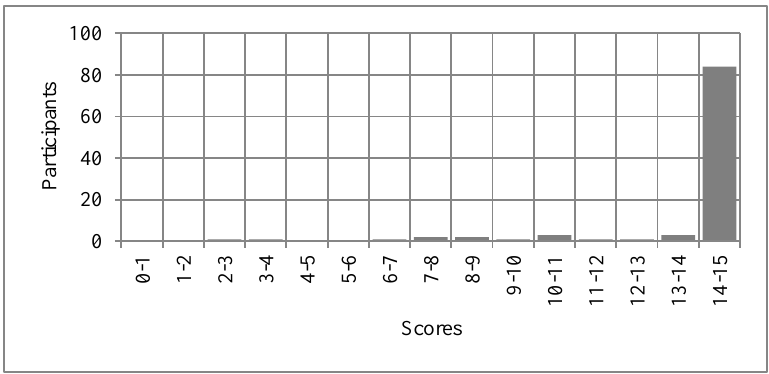
Fig. 4. Testing results on the topic "Charged Particles Movement in Electric and Magnetic Fields" with an extended time interval for solving tasks.